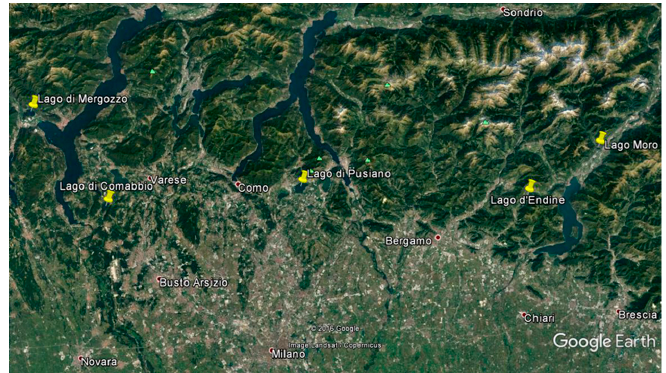
Figure 1. Satellite view of studied lakes (from Google Earth).